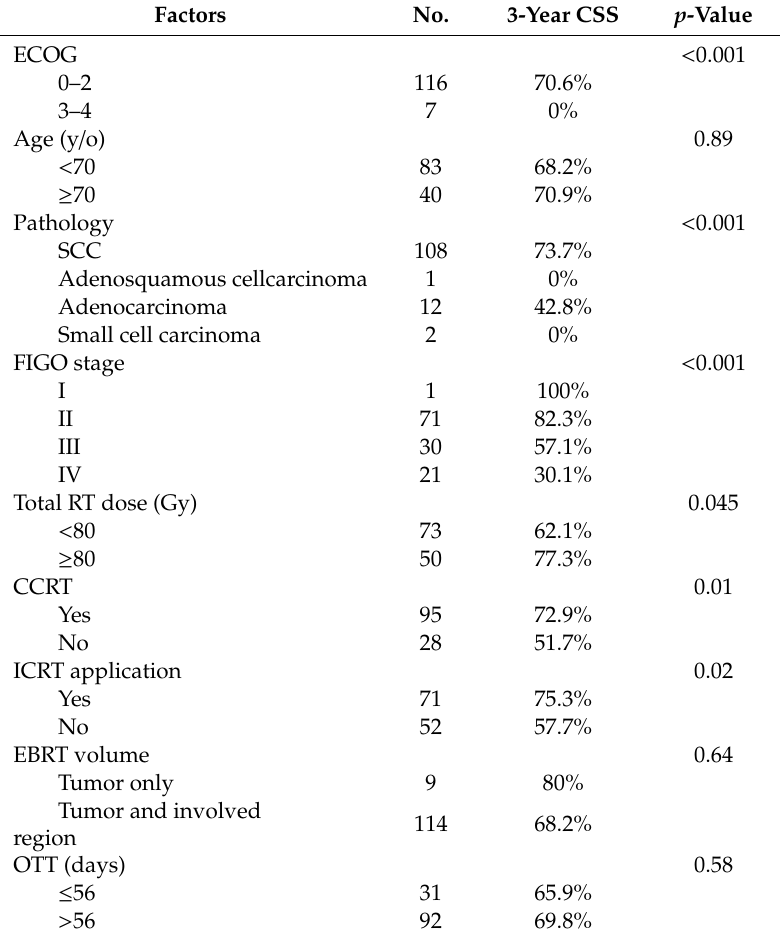
Table 3. Univariate analysis for prognostic factors of CSS in all eligible